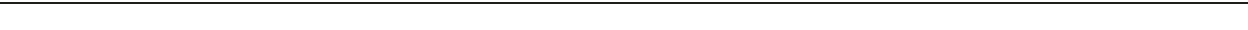
Fig. 9 n c DHPR mice do not show compensatory regulation of key triadic EC coupling proteins. a Schematic representation of the skeletal muscle triad with T-tubular invagination (T-tubule) of the sarcolemma adjacent to the sarcoplasmic reticulum Ca 2+ store (SR). TaqMan qPCR assay (comparative C T method) on skeletal muscle from neonatal mice revealed that none of the investigated key EC coupling and Ca 2+ handling proteins is transcriptionally up- or down-regulated ( P > 0.05) in nc DHPR mice ( n = 18) compared to wt controls ( n = 18). All PCRs were performed in triplicates on 18 fi rst strand replicates from 9 pups. For each gene of interest, the expression level was normalized to the expression of the reference gene EEF1A2 (Eukaryotic translation elongation factor 1 alpha 2) 66 . Comparable results were obtained from SOL and EDL muscles of adult mice with EEF1A2 as the reference gene (Supplementary Fig. 10). Abbreviations: CSQ, calsequestrin; DHPR α 1S , dihydropyridine receptor α 1S subunit; NCX, Na + – Ca 2+ exchanger; Orai, Ca 2+ release- activated Ca 2+ channel; PMCA, plasma membrane Ca 2+ -ATPase; RyR, ryanodine receptor; SERCA, sarco/endoplasmic reticulum Ca 2+ -ATPase; STIM, stromal interaction molecule; TRPC, transient receptor potential cation channel. b Quantitative western blot analysis revealed no compensatory translational regulation ( P > 0.05) of crucial proteins involved in EC coupling and Ca 2+ handling in the nc DHPR mouse ( n = 3) compared with wt controls ( n = 3). Band densities, quanti fi ed by densitometry, were standardized to GAPDH and normalized to the wt control sample on each gel. The corresponding western blots are shown in Supplementary Fig. 11 and in toto in Supplementary Fig. 12. Bars represent mean ± s.e.m. fold-change relative to wt;